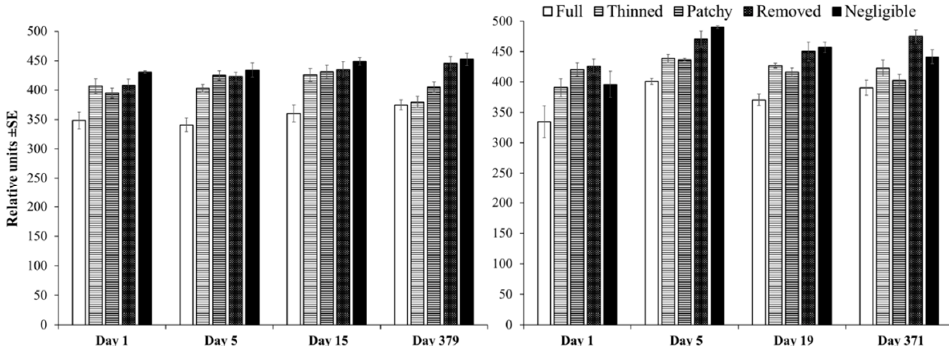
side) and Bridgewater Bay (right hand side).